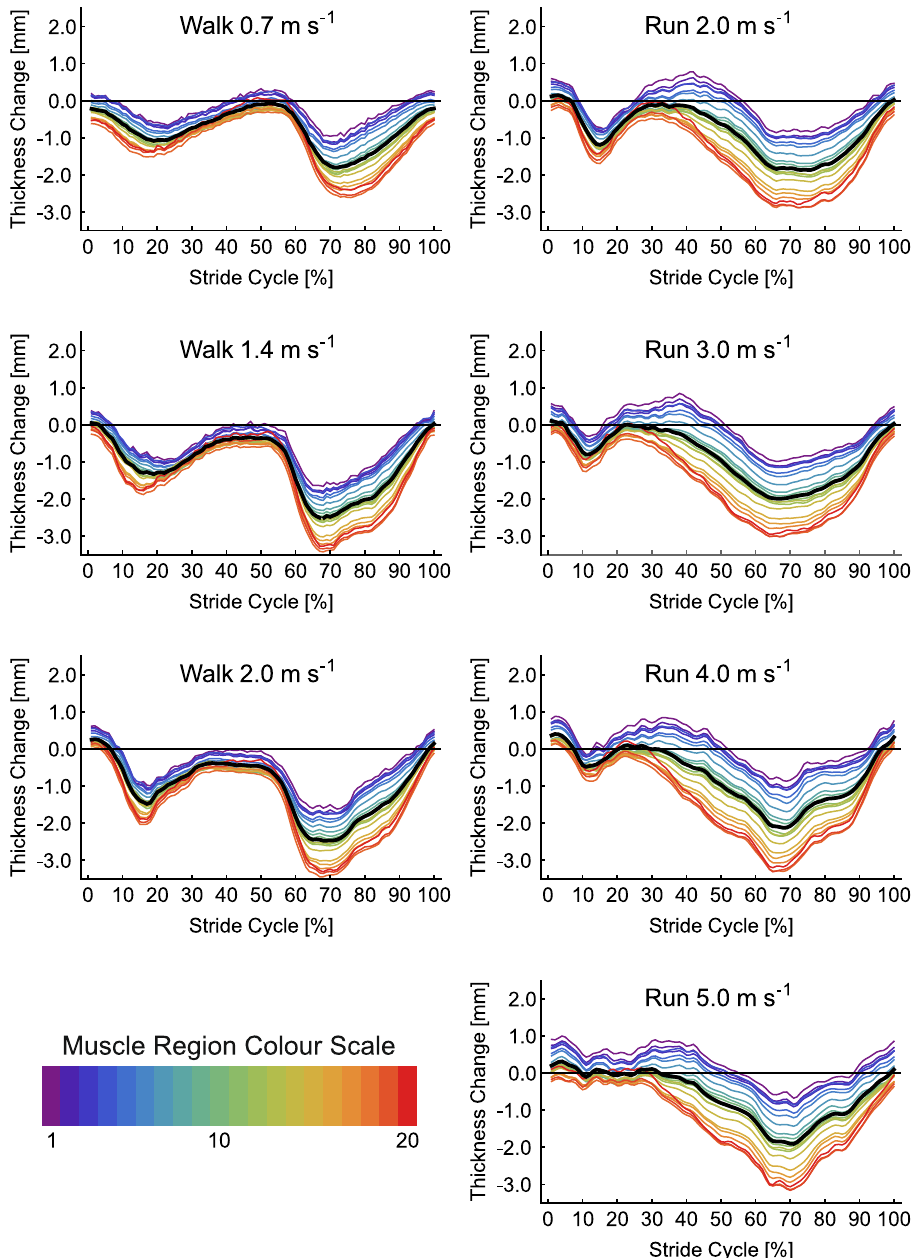
Figure 5. Change in thickness of medial gastrocnemius muscle a function of stride cycle for each of the seven locomotor conditions studied. Twenty coloured lines represent the change in thickness at each point along the length of the muscle (see colour scale bar and Fig. 1). The thick black line represents the mean